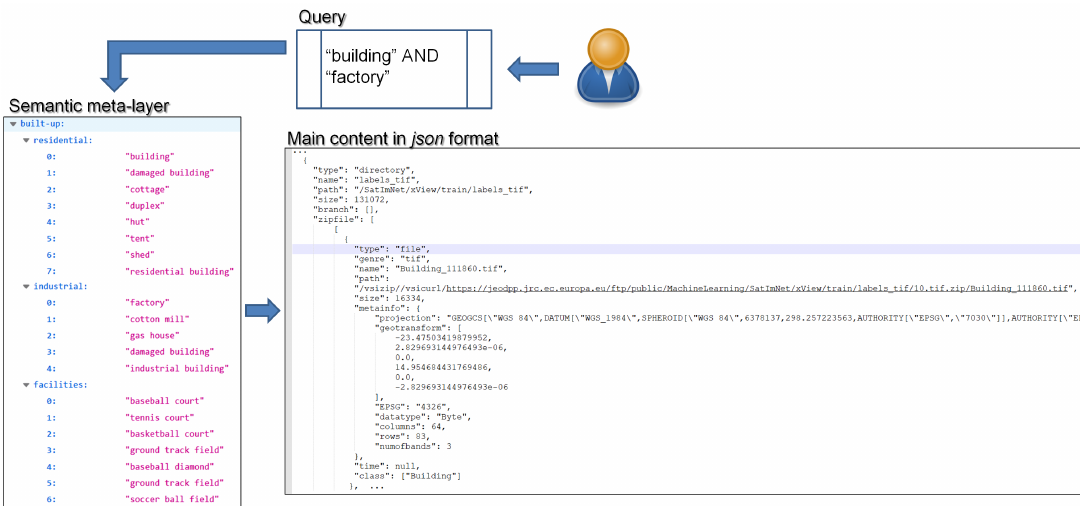
Figure 1. Schematic representation of the information retrieval task: the user forms a query